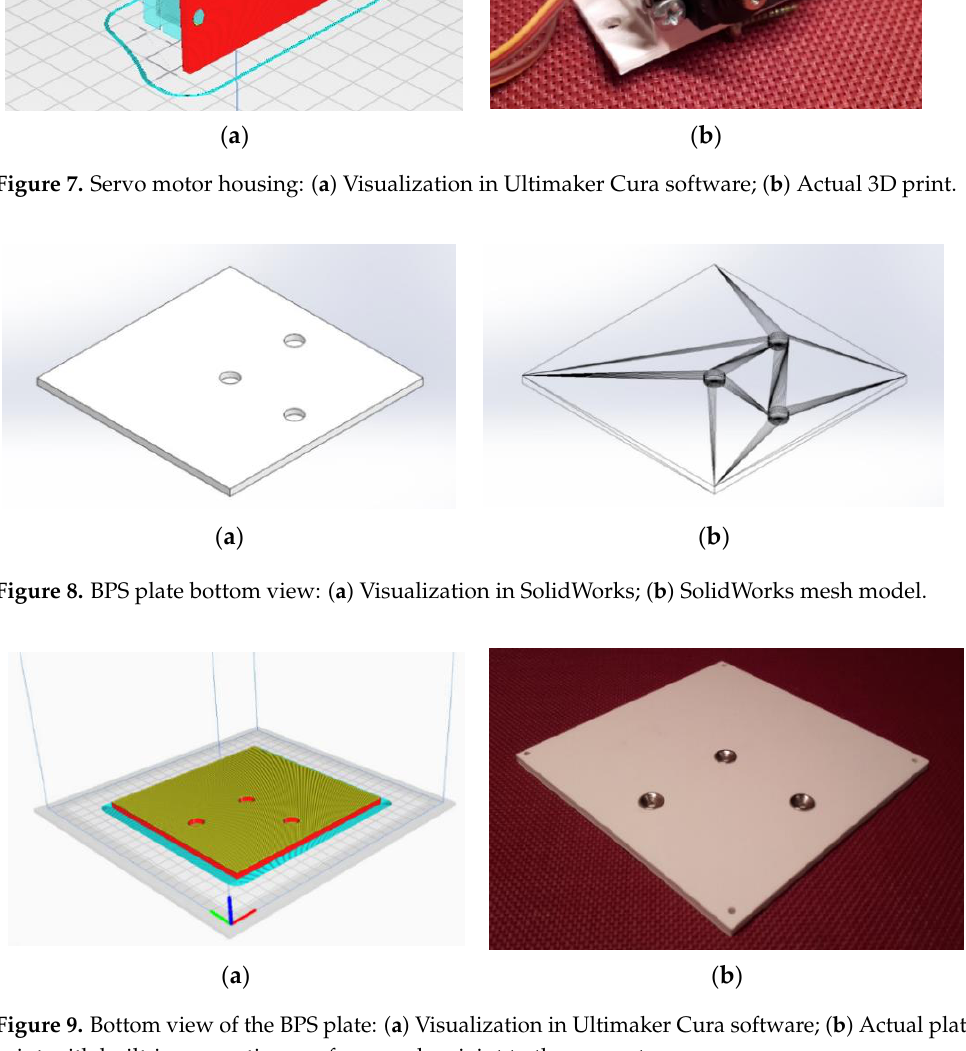
plate print with built-in magnetic cups for spaceless joint to the magnets. print with built-in magnetic cups for spaceless joint to the